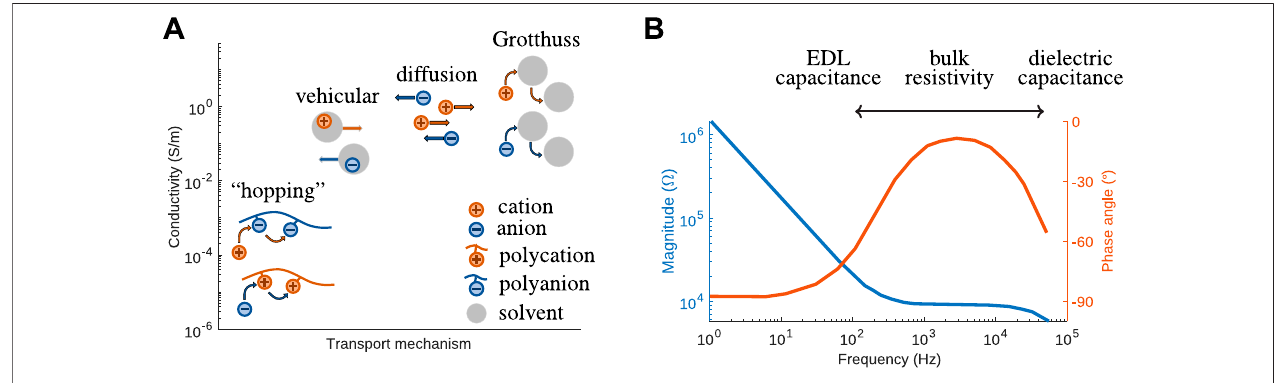
FIGURE 3 | (A) Conductivity achieved by different ion transport mechanisms. (B) Typical Bode plot for a polyelectrolyte system, denoting regions where signal transmission is dominated by: EDL capacitance, bulk resistivity, and dielectric capacitance. Experimental data is obtained by impedence spectroscopy on PSS [26].